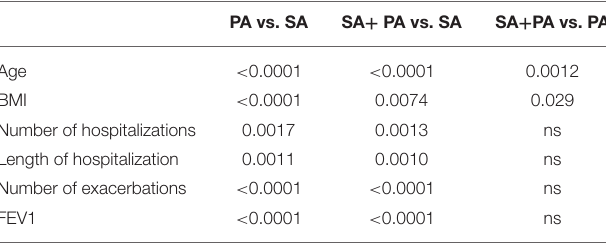
TABLE 2 | P-values for continuous variable comparisons between SA mono-infected (SA), PA mono-infected (PA) and co-infected groups (SA + PA). PA vs. SA SA + PA vs. SA SA + PA vs.